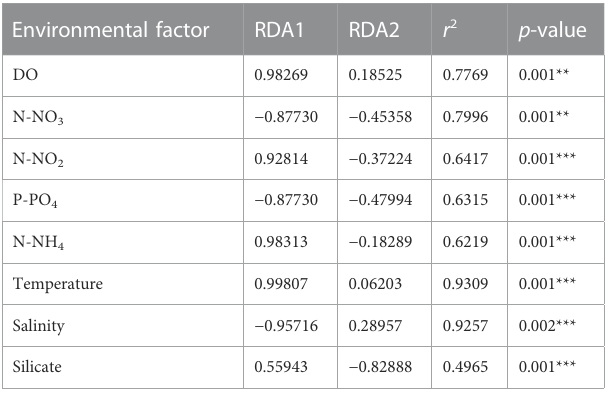
TABLE 1 RDA results for the Changjiang Estuary. Environmental factor